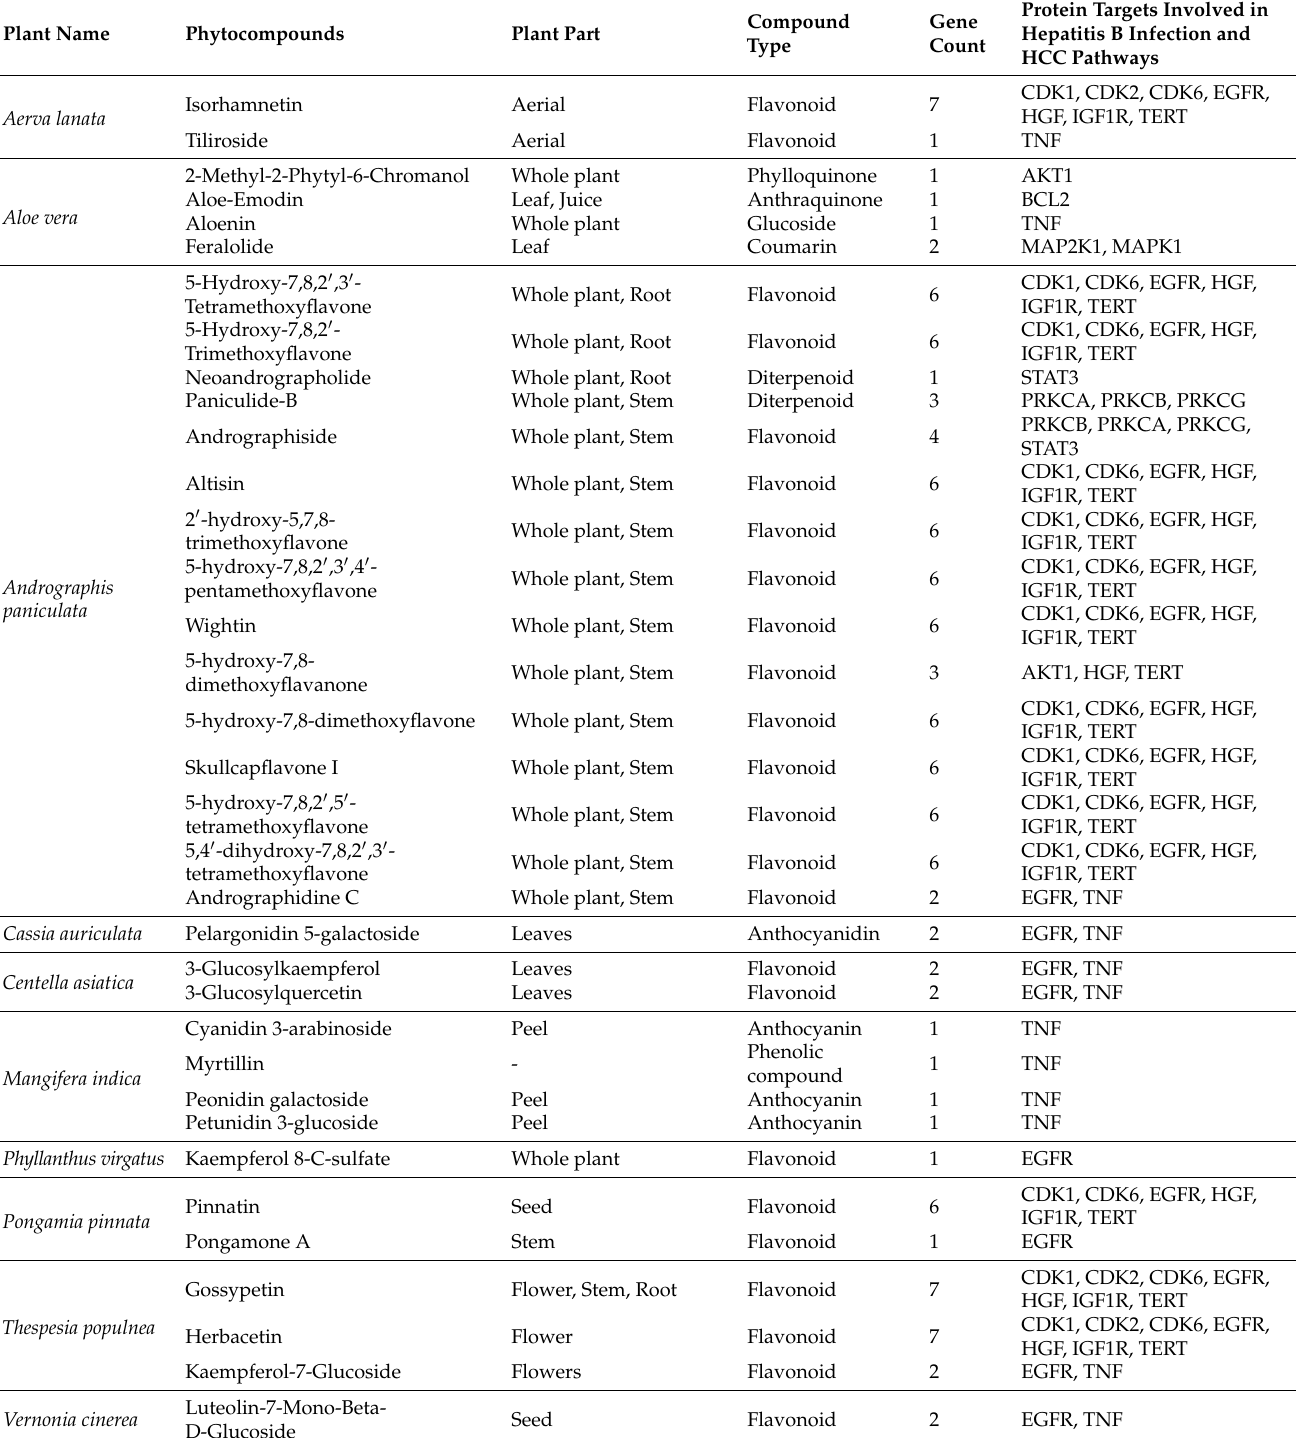
Table 2. Phytocompounds and their probable predicted protein targets involved in hepatitis B infection pathways and associated hepatocellular